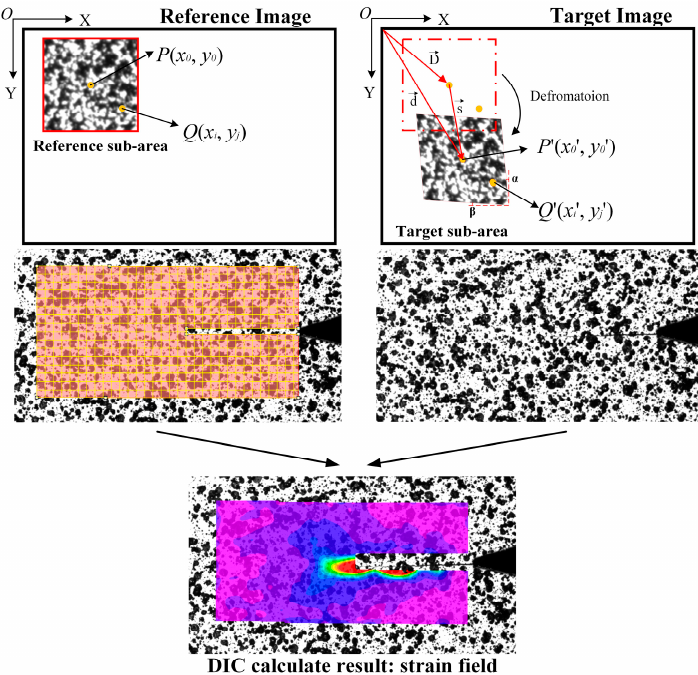
Figure 11. DIC Figure 11. DIC Principle.